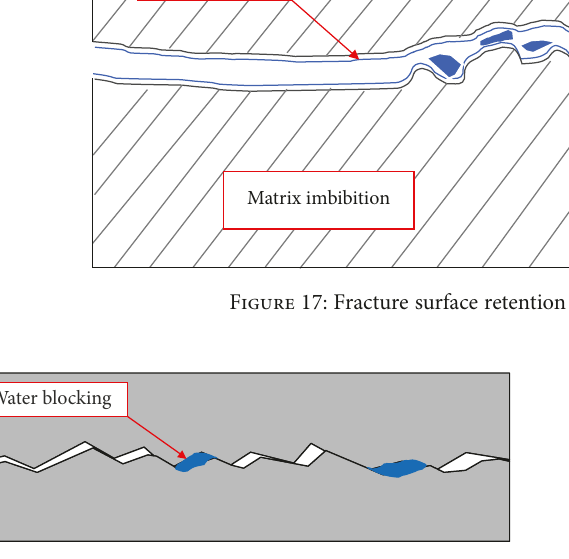
Figure 18: Fracture “ locking. ”